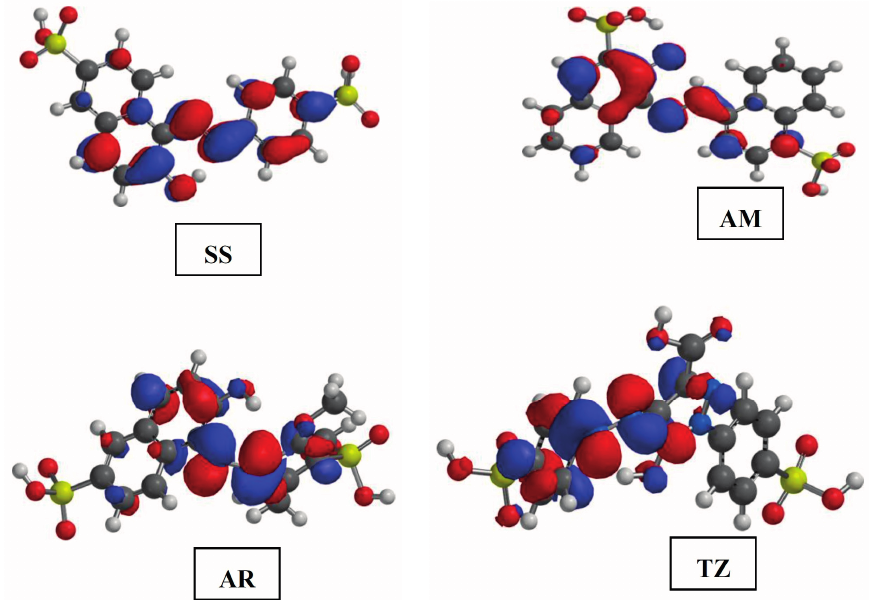
Figure 6. The lowest unoccupied molecular orbitals (LUMO) electron density surfaces for the studied